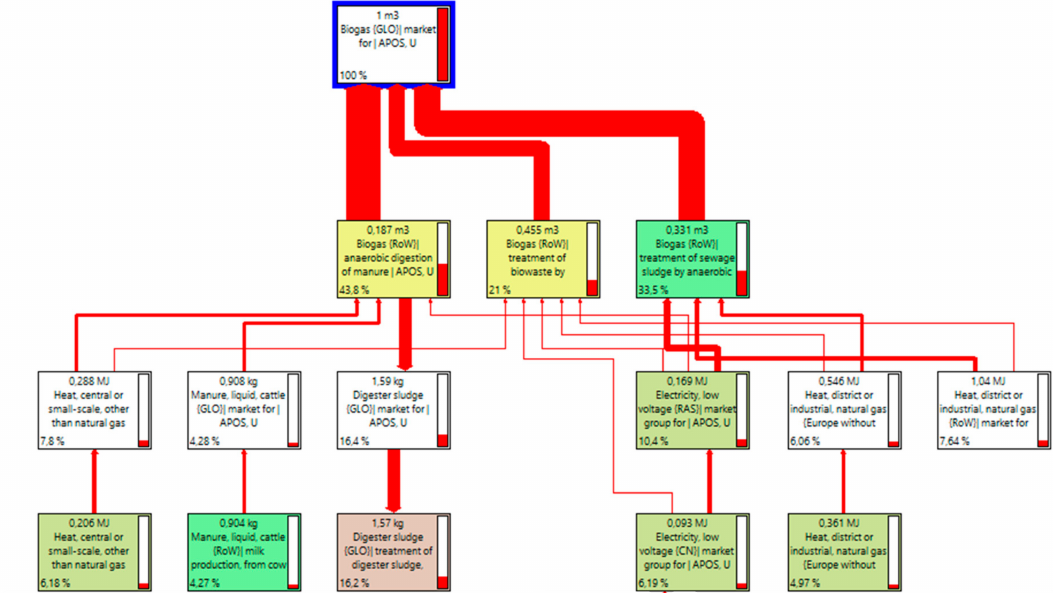
Figure 3. Contribution of different inputs flow to the production of 1 m 3 of biogas (referred to global warming impact category, with 4% graphical cut off). The thickness of the arrows is proportional to the contribution